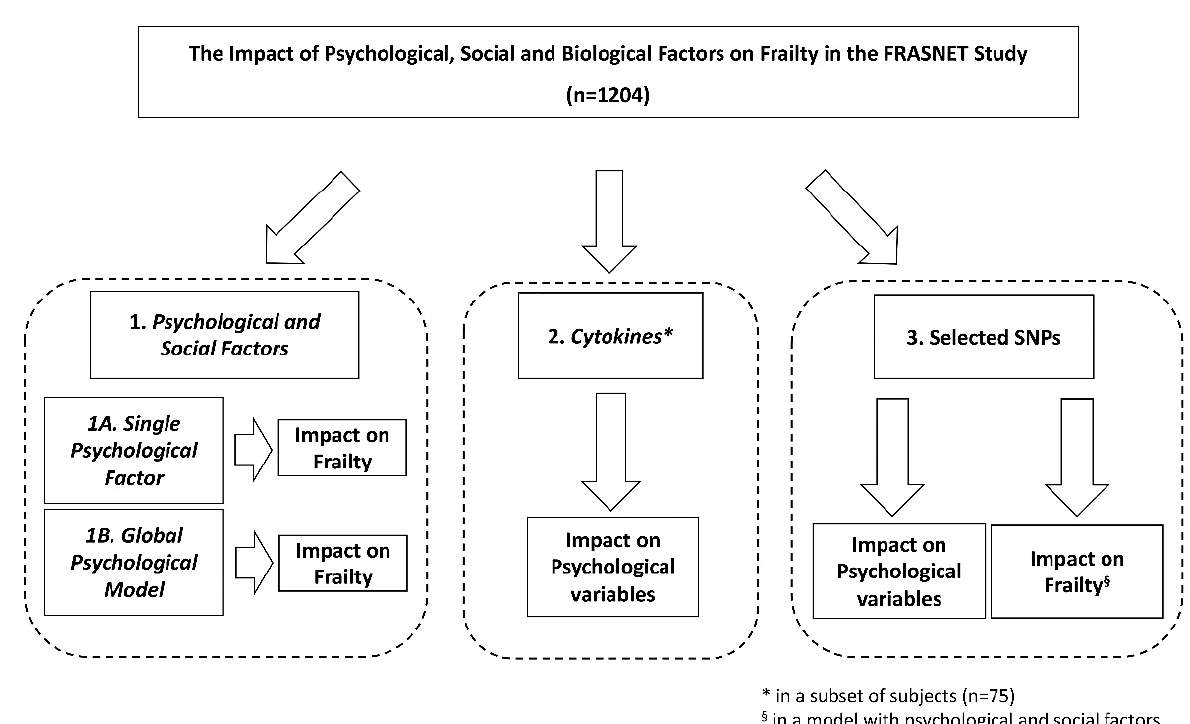
Figure 2. Schematic representation of the analyses performed on the recruited FRASNET cohort. SNPs = single nucleotide polymorphisms.